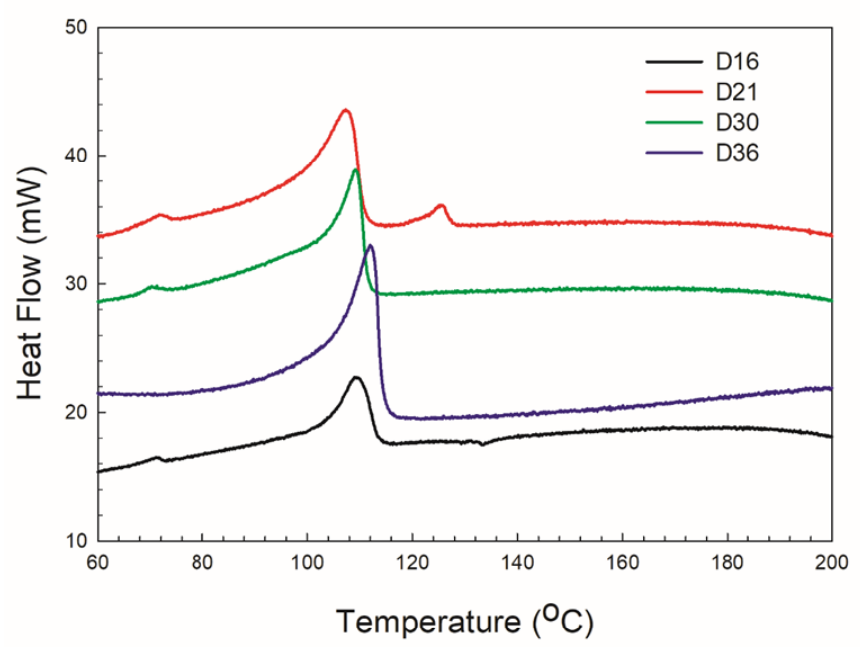
Figure 2. DSC curves (second heating) for the initial polyethylene foams.